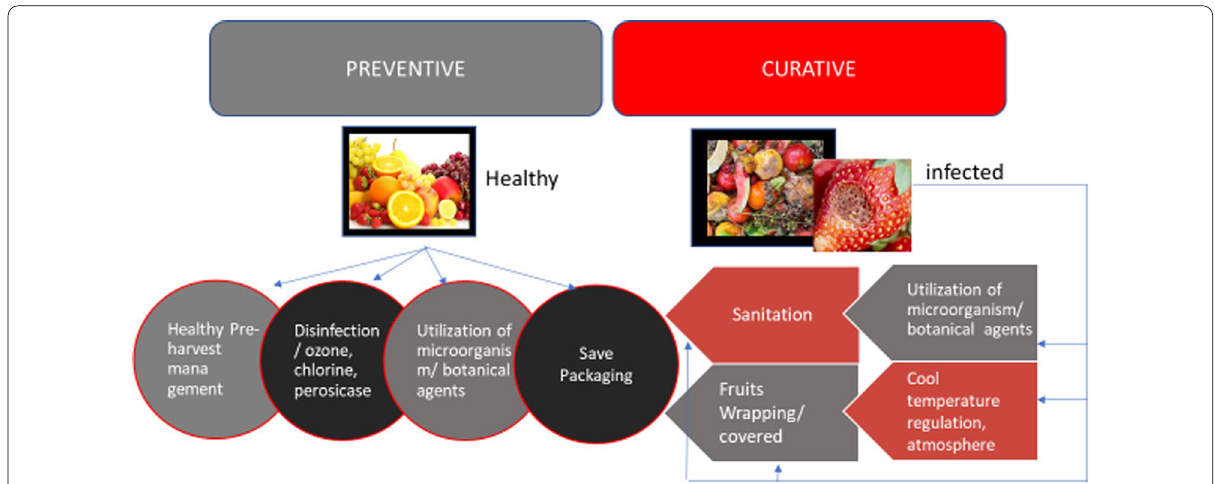
Fig. 2 Integrated postharvest disease control strategies for citrus, apples, grapes, and strawberries